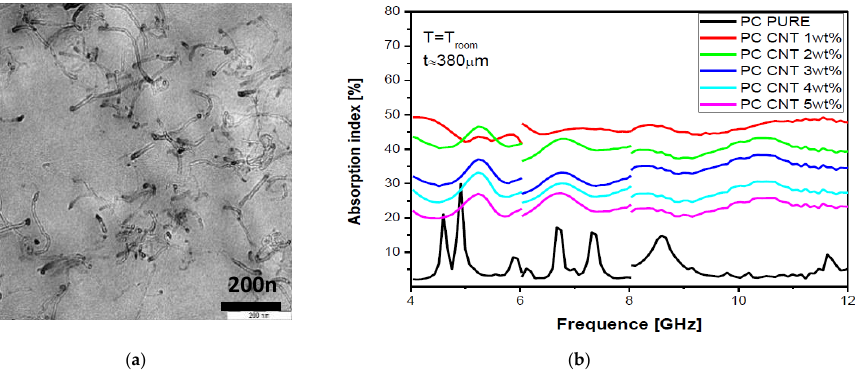
Figure 15. ( a ) TEM micrograph of PC-CNT nanocomposite ( b ) absorption index from equation (2) for PC-CNT nanocomposite.